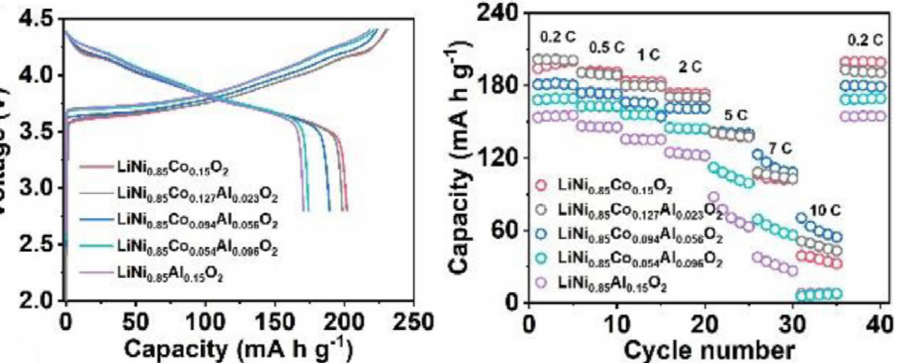
Figure 12. Charge/discharge and rate capacity curves for Al-doped LiNi 0.85 Co 1.5 − x Al x O 2 cathodes. Reproduced with permission [58].